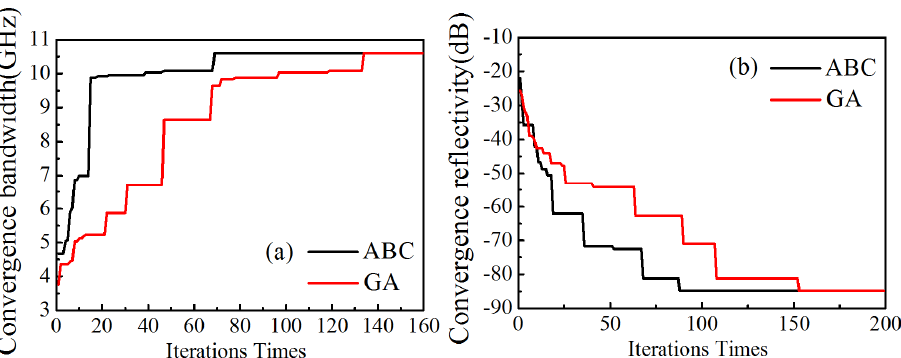
Figure 10. The convergence velocity comparison of two algorithms for the optimal bandwidth ( a ) and optimal reflectivity ( b ) for three-layer materials.